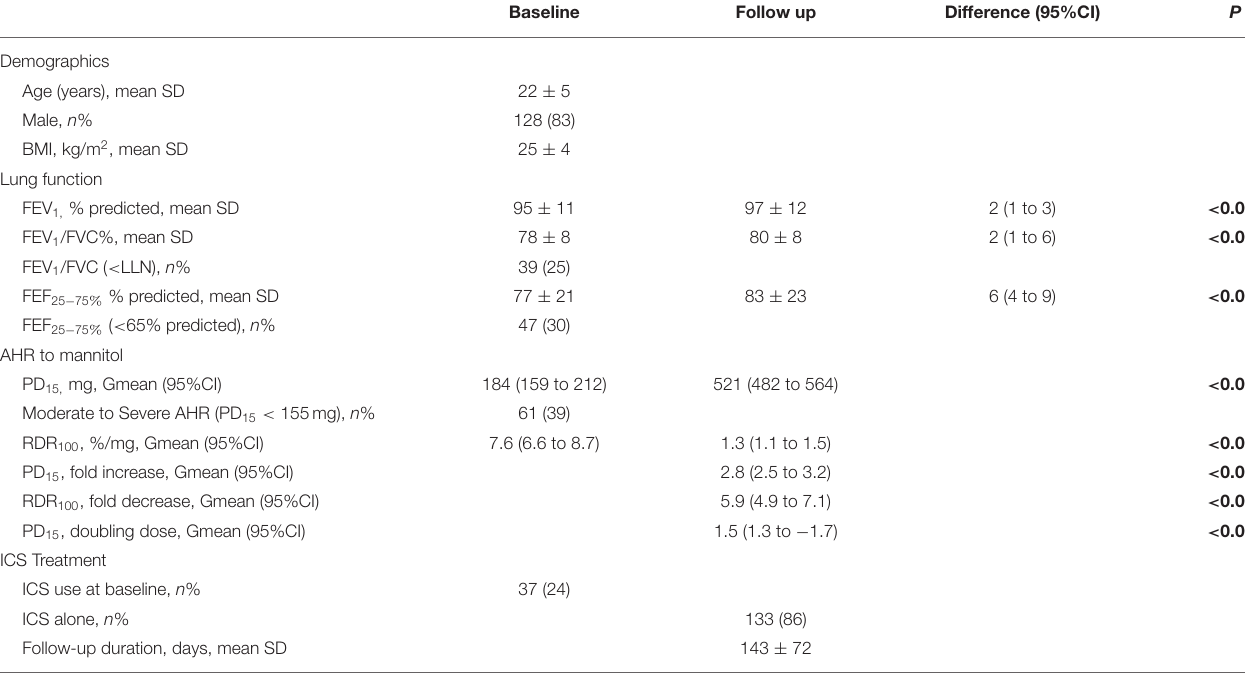
TABLE 1 | Total cohort ( n = 155): Baseline and ICS follow up: Demographics, lung function, AHR severity, ICS therapy at baseline visit, ICS type and duration of follow up period.